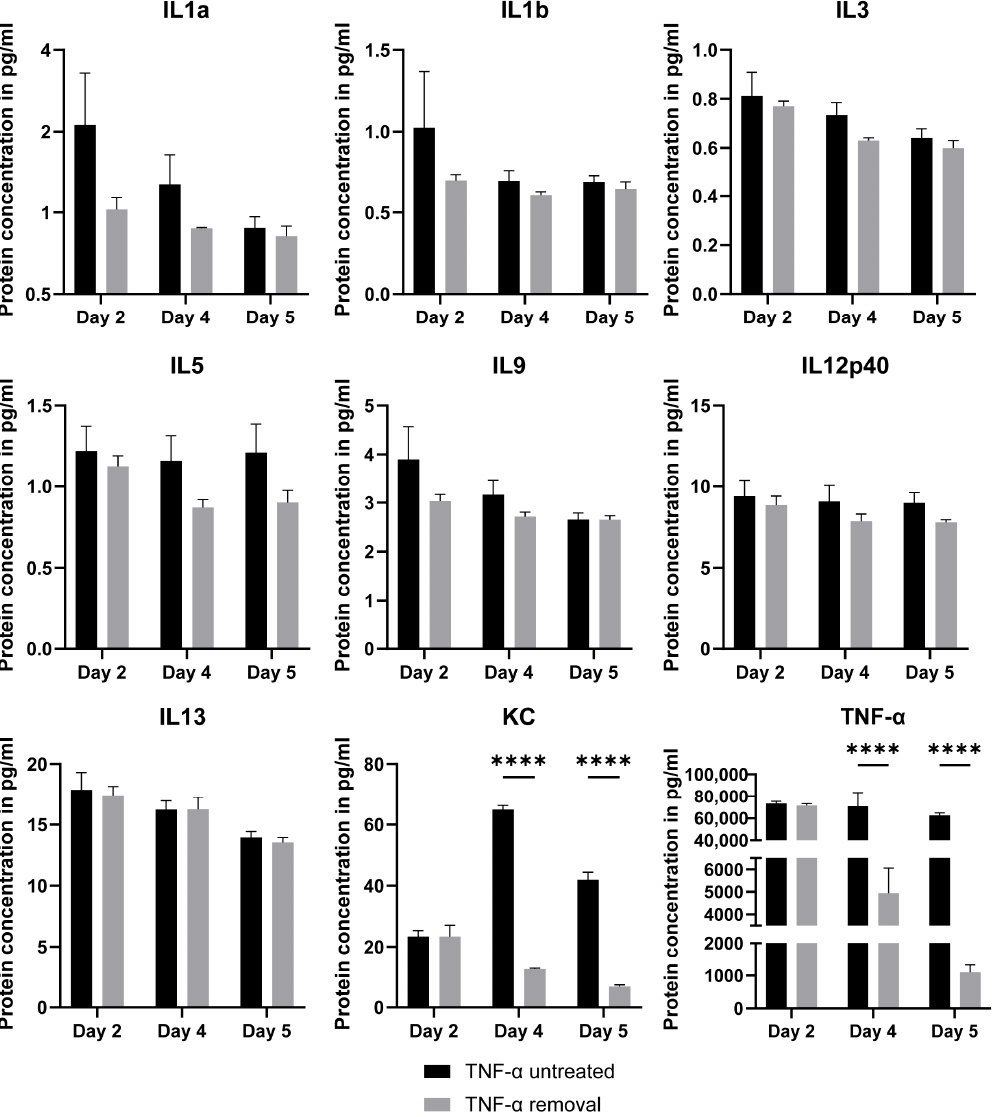
Figure 4. Luminex assay for TNF- α -treated intestinal organoids. Secretion of the cytokines IL1 α , IL1 β , IL3, IL5 IL9, IL12p40, IL13, KC, and TNF- α was identified in organoid culture medium upon addition of 64 ng/mL of TNF- α (TNF- α -untreated). Except for the KC and TNF- α , removal of TNF- α from the medium did not seem to strongly affect the production of these proteins. Data are presented as the mean ± SEM ( n = 4). ****, for p < 0.0001.